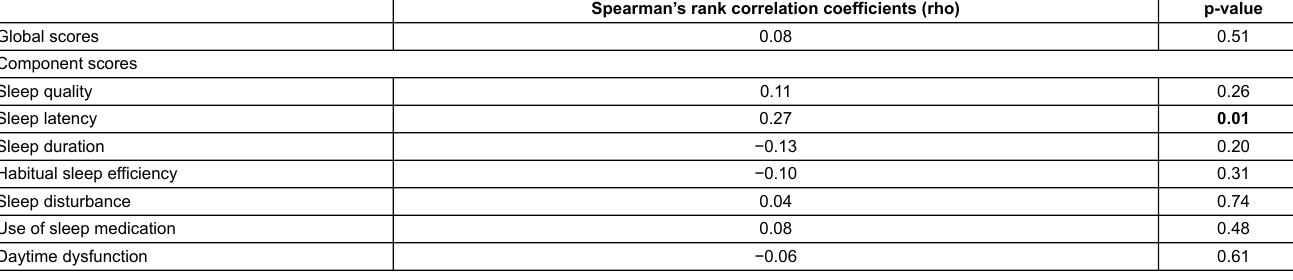
Table 4: Correlations between Pittsburgh Sleep Quality Index (PSQI) global and component scores and single-item mean score. Spearman’s rank correlation coefficients